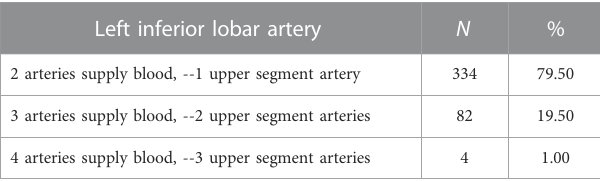
TABLE 1 Basic data of all the subjects.